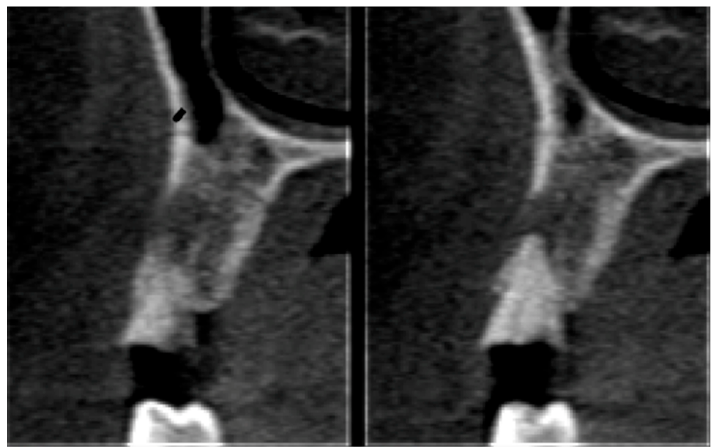
Figure 10. CT images of tooth 14 prior to the procedure.